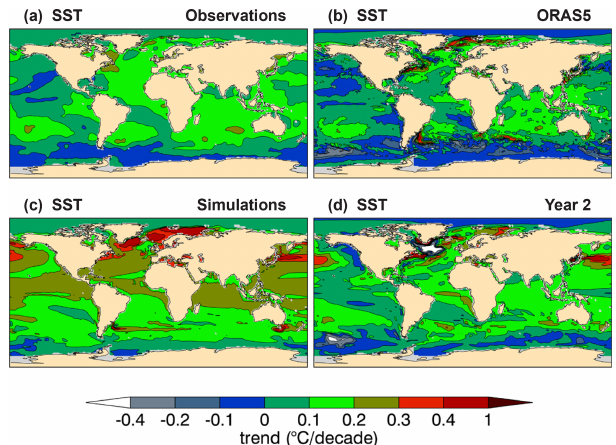
Figure 4. Linear trends of annual mean sea surface temperature for (a) observations, (b) ORAS5, (c) uninitialized simulations, and (d) Year 2 hindcasts. The verifying observations are from the ERSSTv5 data set (Appendix